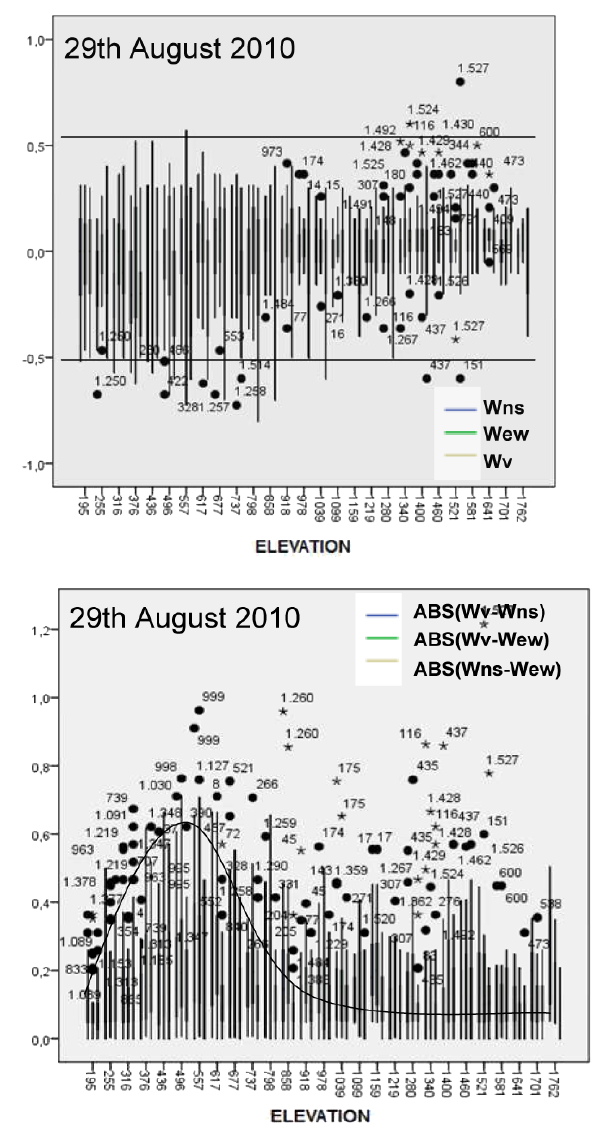
Fig. 4. Breeze pattern: box plots on 29 August 2010. (top) Vertical velocities versus height. (bottom) Absolute values of the differences between velocities versus height. x axis (height in ma.s.l. – above sea level). y axis (velocity in ms − 1 ) . Black line denotes the enve- lope curve of the 3rd